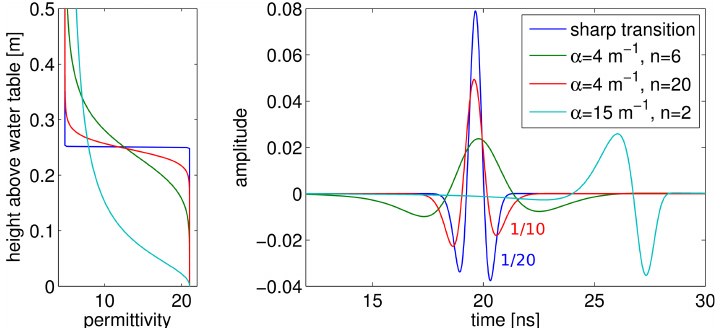
Fig. 5. Simplified van Genuchten parameterisation (Eq. 3): permittivity profiles (left panel) and corresponding modelled reflections (right panel) with amplification factor if used. Starting from a realistic set of parameters (green), the impact of n is shown compared to a sharp transition (blue), while the cyan curve shows an unrealistic parameter set reproducing the measured signal.